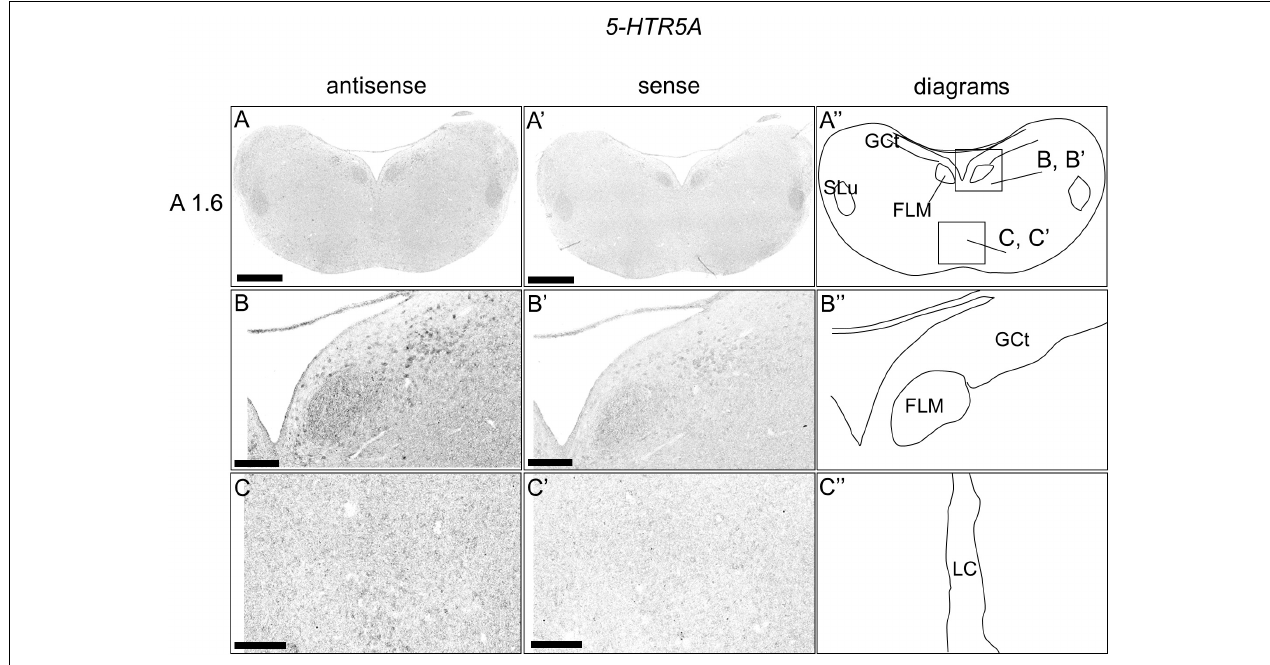
FIGURE 7 | In situ hybridization of 5-HTR5A in the P1 chick brainstems. Digoxigenin-labeled RNA antisense (A–C) and sense (A’–C’) 5-HTR5A probes were used for in situ hybridization in coronal sections of P1 chick brains. To evaluate the expression patterns of 5-HTR5A , sections of four chicks were analyzed, and the representative levels of sections (A1.6) are shown. (A”–C”) Diagrams of coronal sections shown in the rightmost panels. The levels of the sections (A 1.6) is in accordance with those mentioned in Kuenzel and Masson’s chick atlas (Kuenzel and Masson, 1988). (B–C,B’–C’) Magnified views of brain areas shown in the boxes in panel (A”) . FLM, fasciculus longitudinalis medialis; GCt, griseum centrale; MR, median raphe; SLu, nucleus semilunaris; P1, post-hatch day. Scale bars = 1 mm (A,A’) and 250 µ m (B–C,B’–C’) .